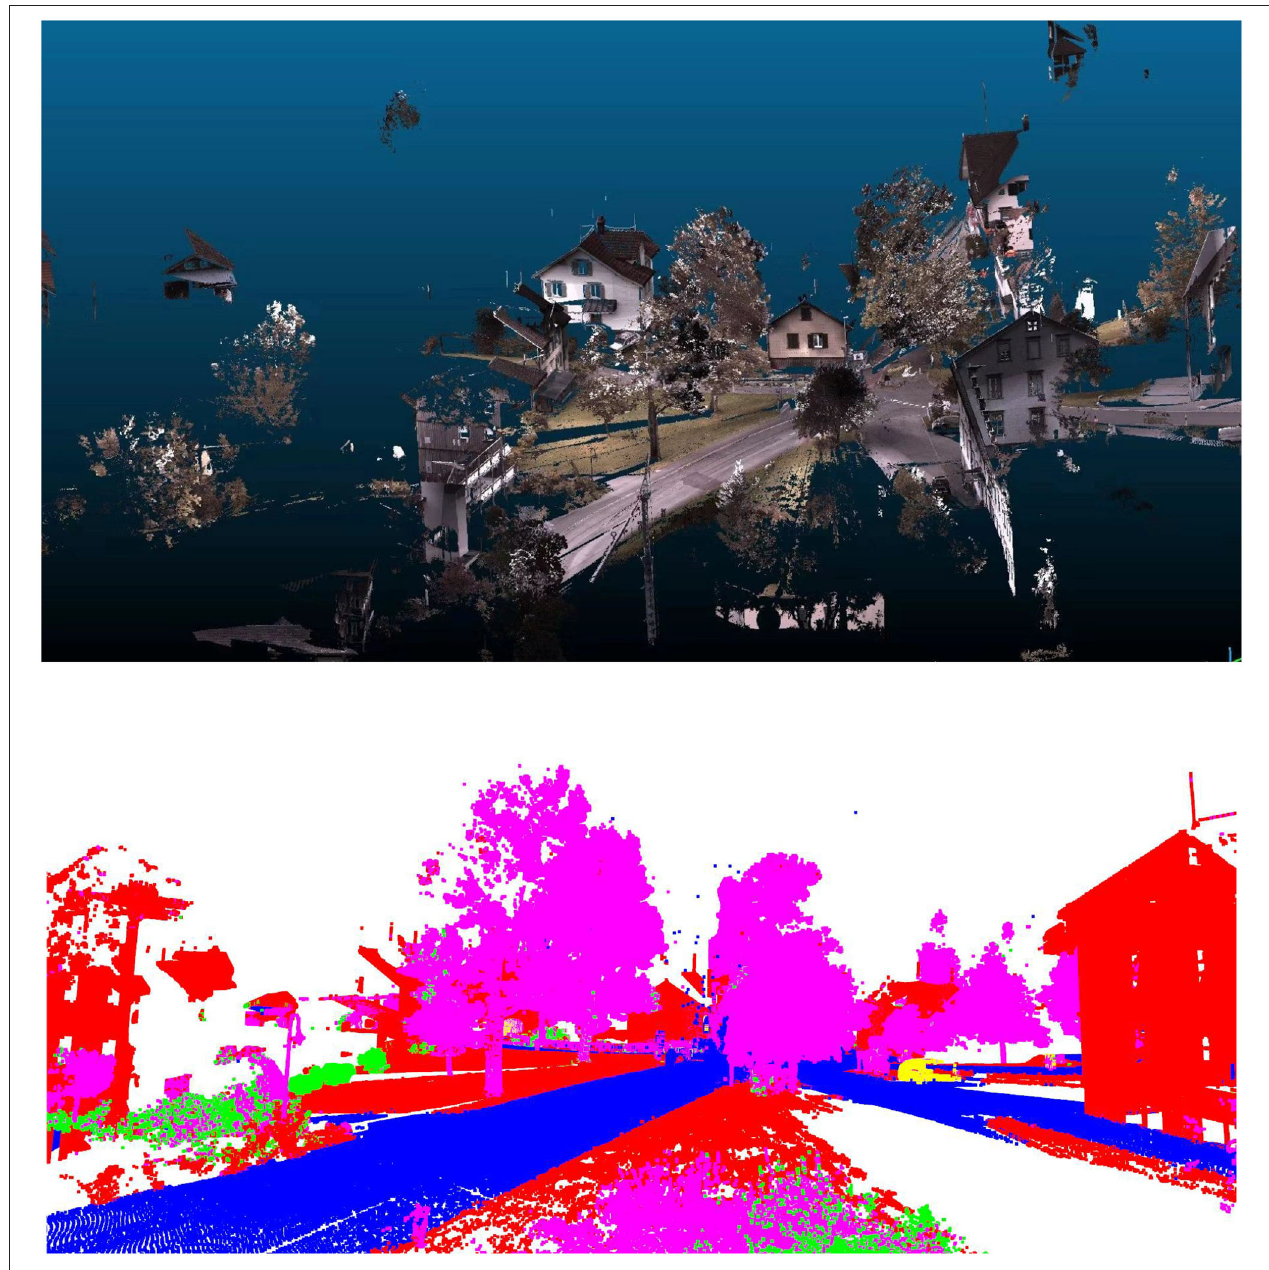
FIGURE 2 | Object prediction recognition